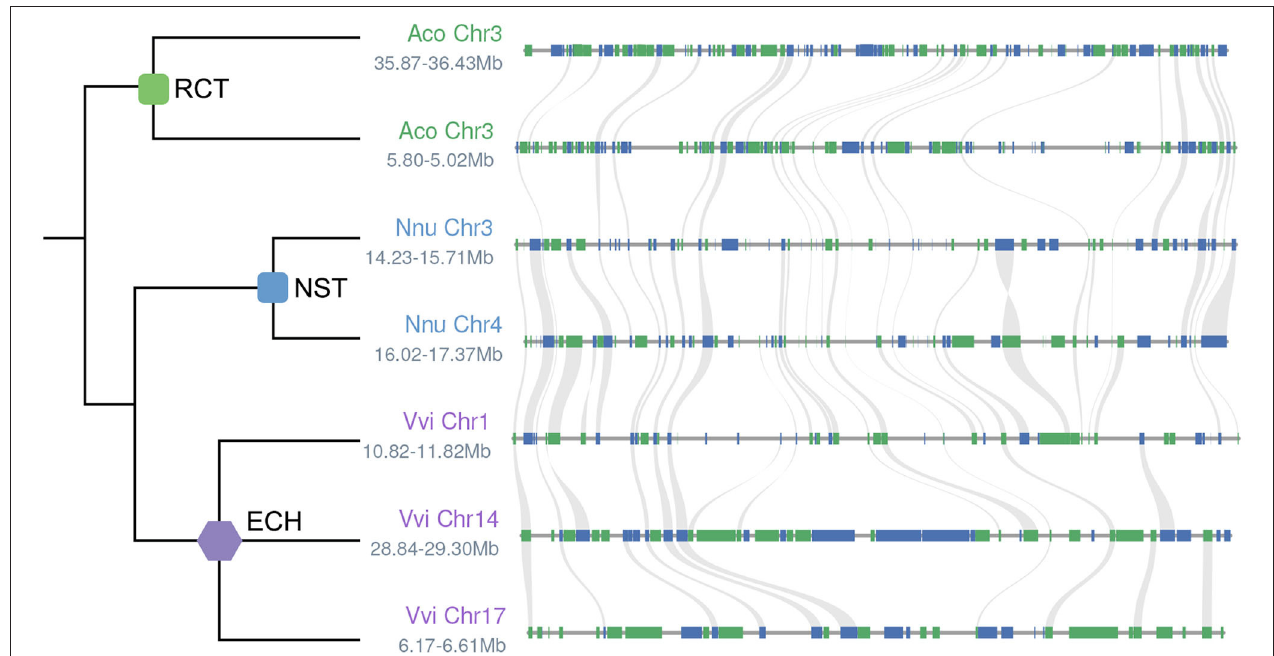
FIGURE 4 | Local alignment in A. coerulea , N. nucifera , and V. vinifera genomes. The phylogeny of homologous regions is shown on the left. The chromosomes of A. coerulea (Vvi), N. nucifera (Nnu), and V. vinifera (Vvi) and the locations on chromosomes are shown on the left side of the chromosome segments. Genes are represented as rectangles and homologous genes between adjacent chromosomal regions are linked with gray